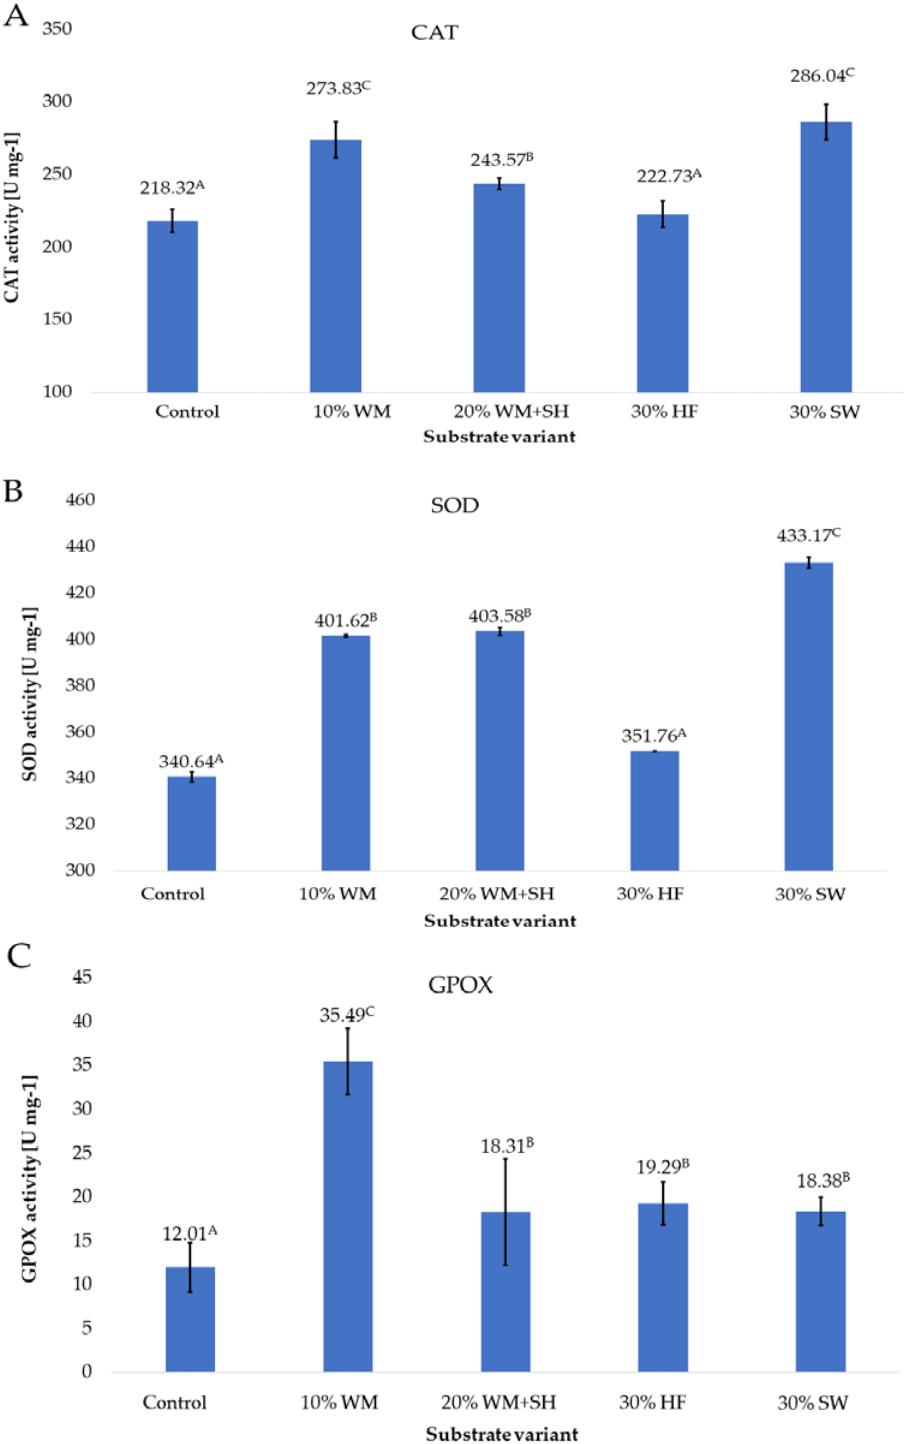
Figure 7. CAT ( A ), SOD ( B ), and GPOX ( C ) enzyme activity in raspberry fruits, depending on the substrate used ( n = 36). Note: Significant differences between the results, depending on the substrate variant used, are marked with different letters. Significant level at p < 0.05. Key: Control—100% coconut fibre; 10% WM—90% coconut fibre + 10% fragmented wood material; 20% WM + SH—80% coconut fibre + 10% fragmented wood material + 10% biochar from sunflower husk; 30% HF—70% coconut fibre + 30% hemp fibre; 30% SW —70% coconut fibre + 30% sheep wool.